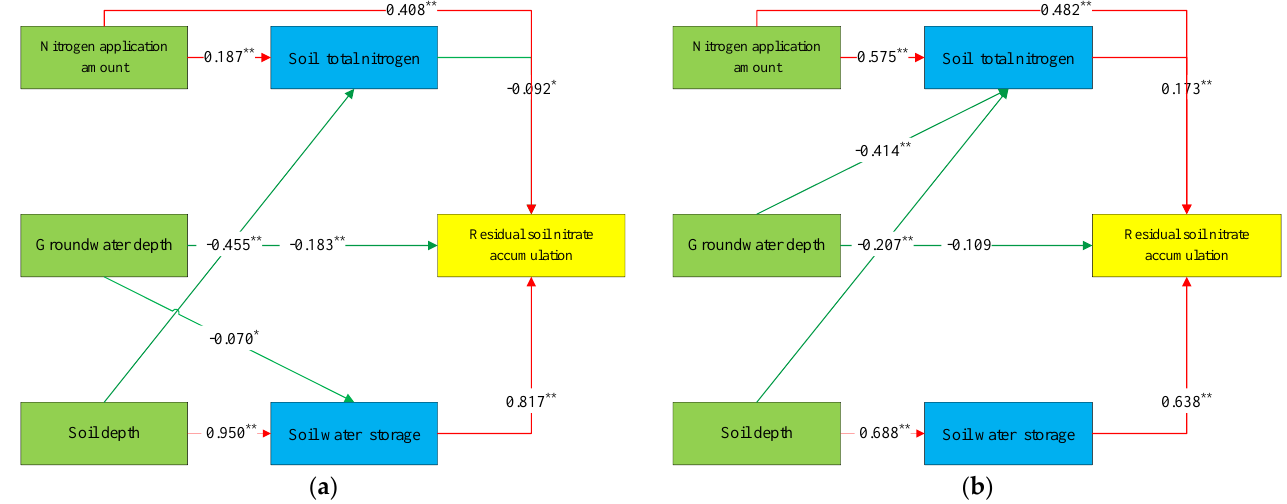
Figure 6. SEMs (structural equation models) fitted to connections among residual soil nitrate accu- mulation and the effects of groundwater depth, nitrogen application amount, and soil factors (soil depth, soil total nitrogen, soil water storage) in summer maize field ( χ 2 = 14.217, DF = 10, GFI = 0.997, CFI = 0.995, RMSEA = 0.051, p = 0.163) and winter wheat field ( χ 2 = 6.623, DF = 10, GFI = 0.990, CFI = 1.004, RMSEA = 0.000, p = 0.761). Numbers adjacent to arrows represent the standardized path coef- ficients( r ) (** p < 0.01, * p < 0.05). ( a ) Summer maize; ( b ) Winter wheat.